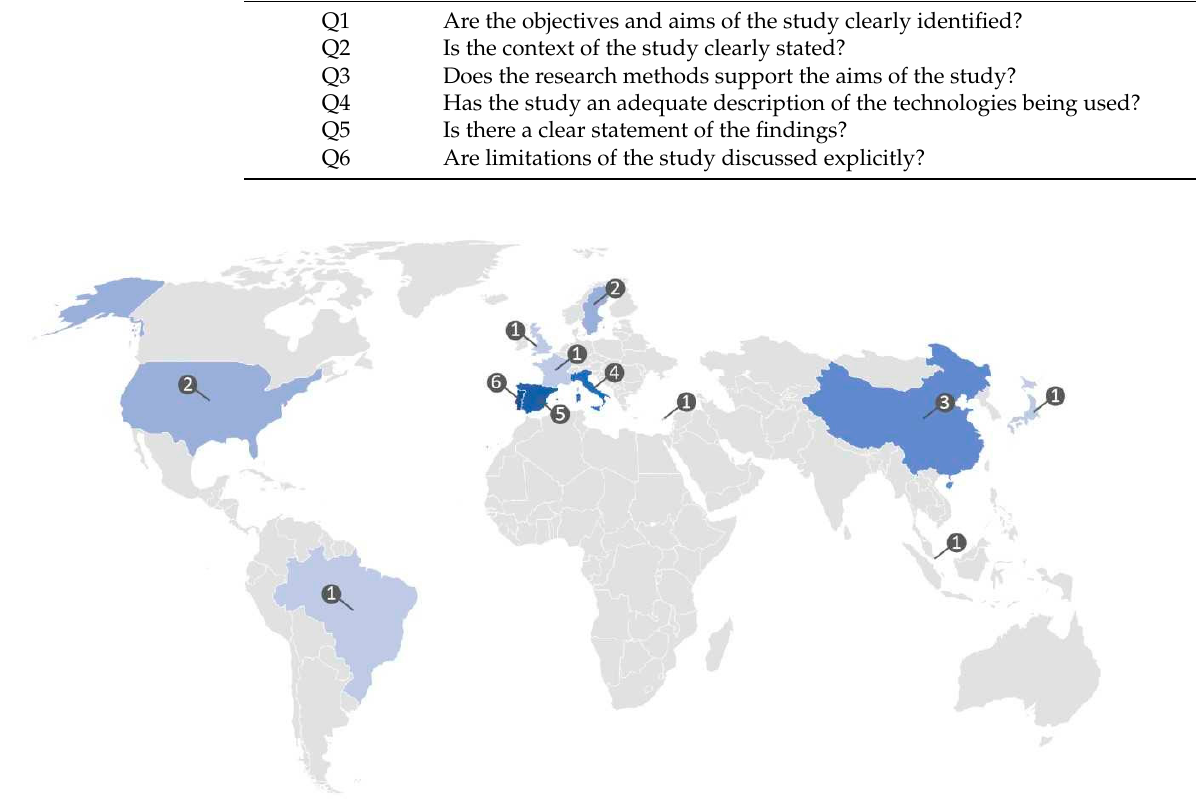
Figure 3. Distribution of the selected articles by country.